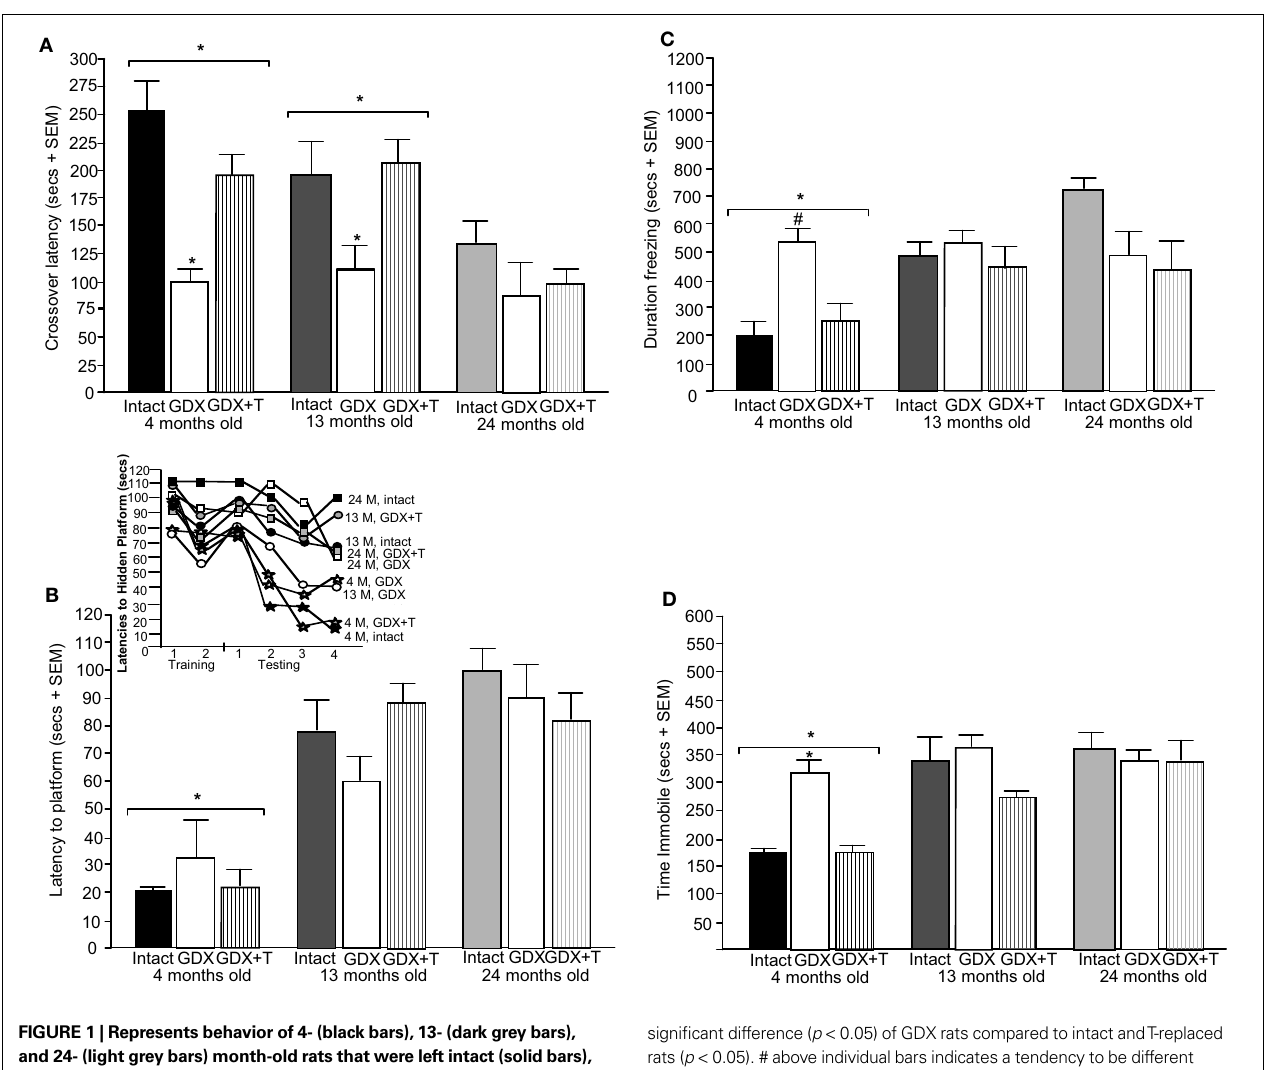
signifi cant difference ( p < 0.05) of GDX rats compared to intact and T-replaced rats ( p < 0.05). # above individual bars indicates a tendency to be different from intact rats ( p < 0.075).* over brackets denotes difference at that age group compared to age groups that do not have a bracket above bars ( p <